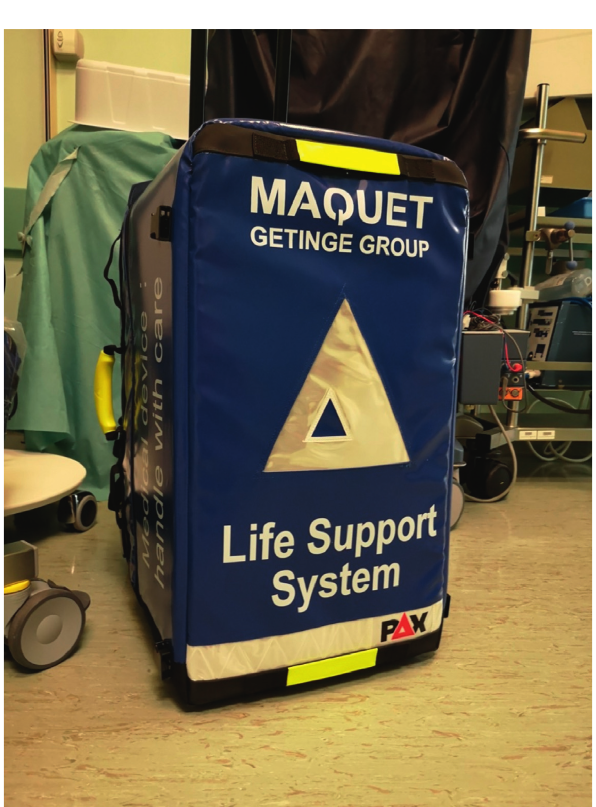
Figure 3: Transport bag for ECMO